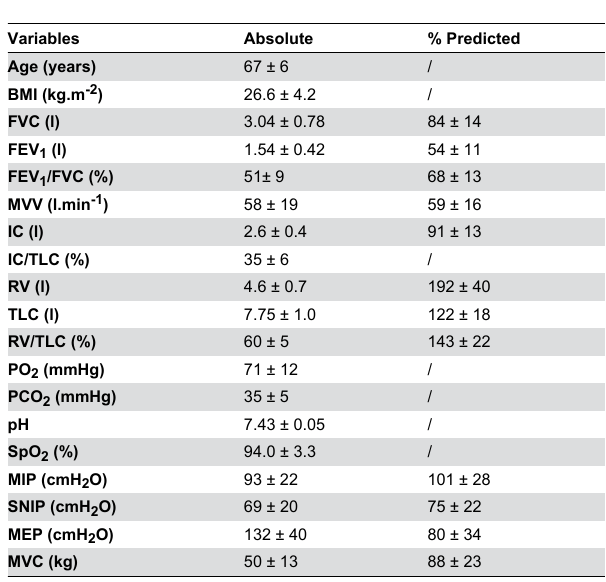
Table 1. Patients’